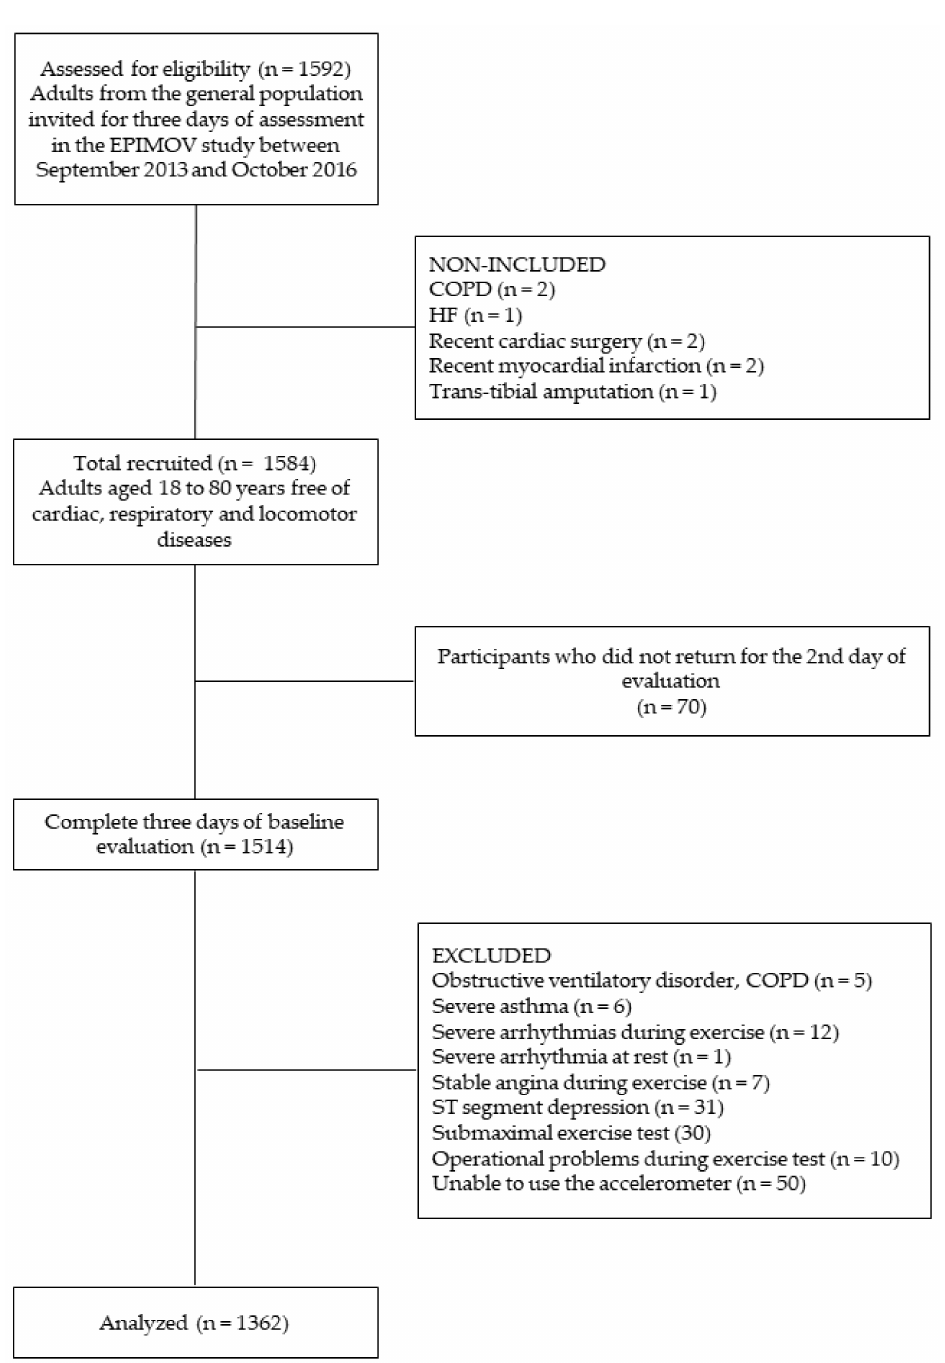
Figure 2. Flowchart of the study. EPIMOV: The Epidemiology and Human Movement Study. COPD: chronic obstructive pulmonary disease. HF: heart